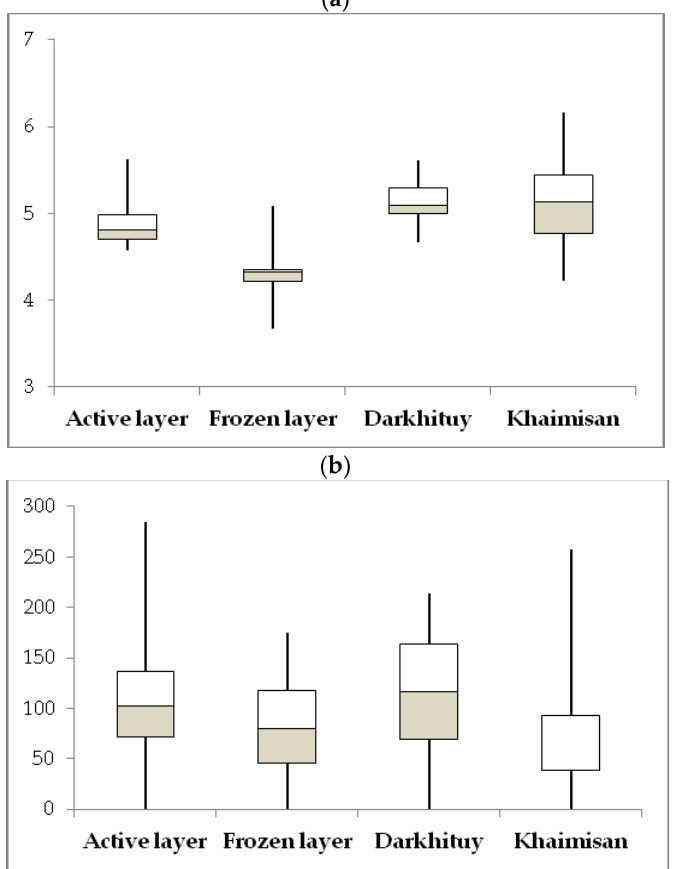
Figure 3. Boxplots of differences in alpha diversity between the active and frozen layers and across habitats in Darkhituy – Khaimisan. All data are presented as the mean ± standard error. ( a ) Shannon diversity index; ( b ) Number of ASVs.